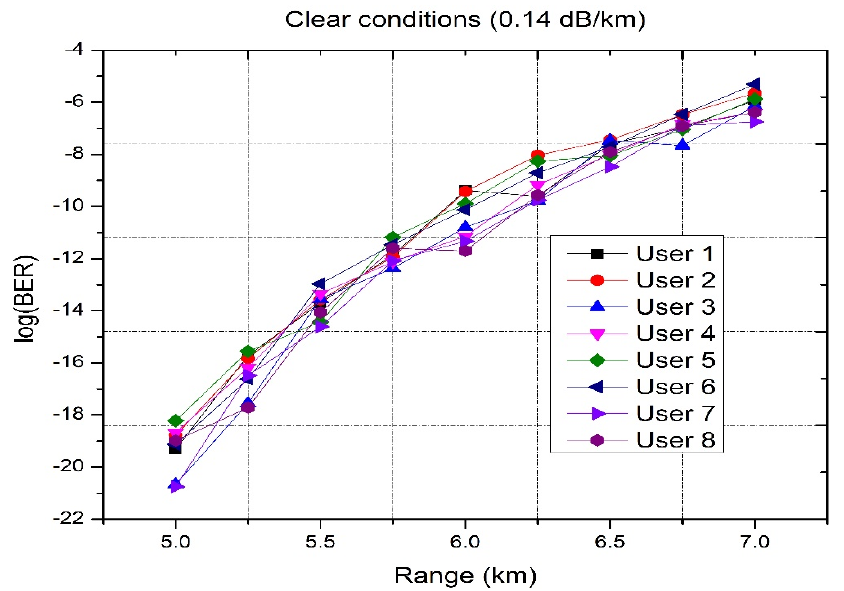
Figure 2. Log (BER) of FSO-PDM/PV-OCDMA system versus FSO link under clear air weather. Table 3. log (BER) values of eight channels of FSO-PDM/PV-OCDMA system at 7 km.